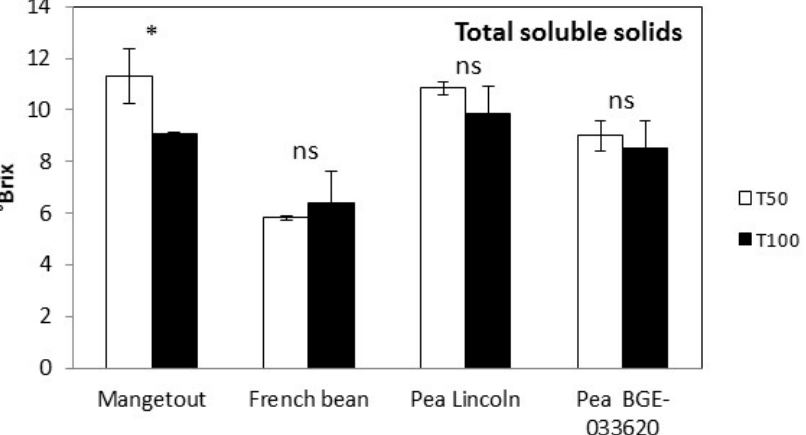
Figure 2. Total soluble solids (expressed as ° Brix) in edible parts of mangetout , French beans and peas grown under normal (T100) and sustained deficit (T50) fertigation tested under protected cultivation conditions. * and “ns” indicate significant differences at p < 0.05, and non-significant differences between treatments (T50 and T100) for each cultivar, respectively (ANOVA followed by Tukey’s multiple range test).